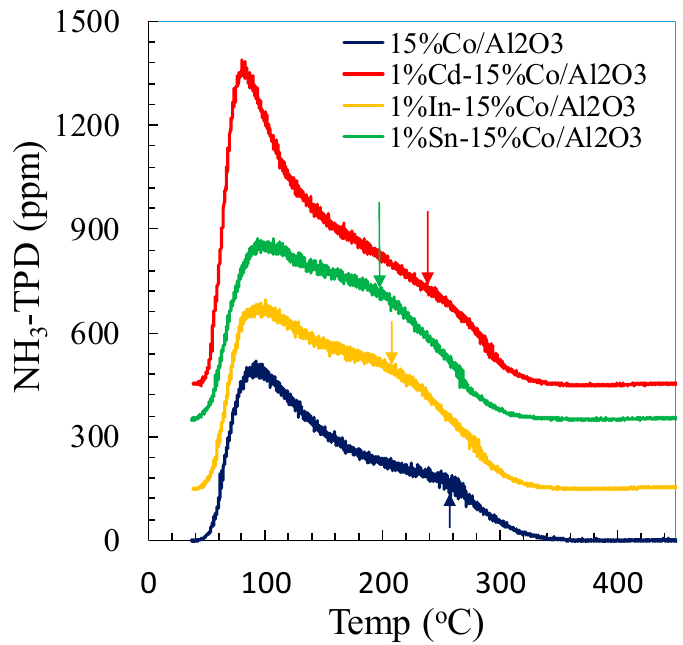
/ Al 2 O 3 catalysts.